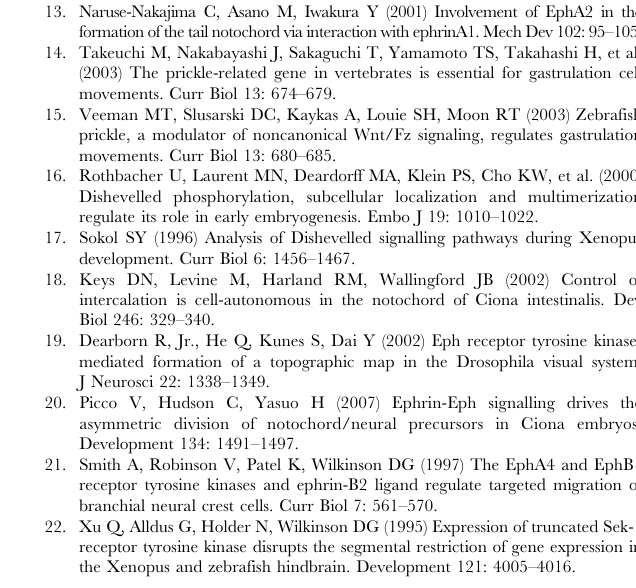
Embryos were stained with phalloidin (green) and DAPI (blue). by immunostaining for myc (red). Lareral view. Anterior is to the